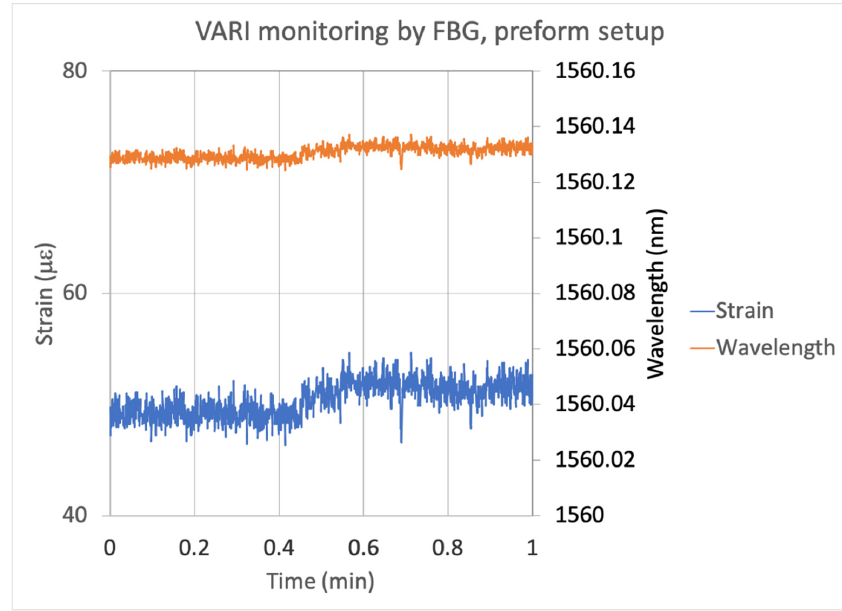
Figure 4. VARI monitoring by FBG, preform setup.